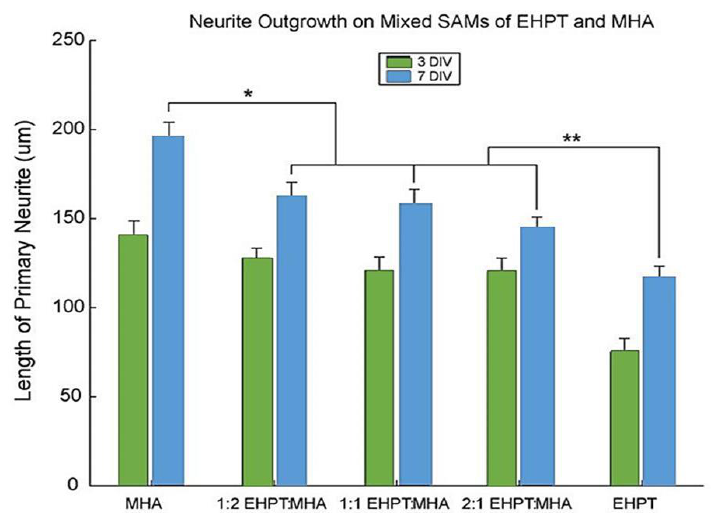
Figure 3. Outgrowth of neurites on pure and mixed EHPT/MHA SAMs at 3 and 7 DIV. Average length of each cell’s primary (longest) neurite is reported. At 3 DIV, only the EHPT group differs significantly from the others ( p < 4.624 × 10 − 5 ). By 7 DIV, pure MHA shows significantly greater outgrowth than all mixed SAMs ( p < 0.0087, denoted by *), and pure EHPT (with protein adsorbed) shows significantly less growth ( p < 0.0233, denoted by **). There is no significant difference at 3 or 7 DIV among the three mixed SAMs tested ( p > 0.3287)